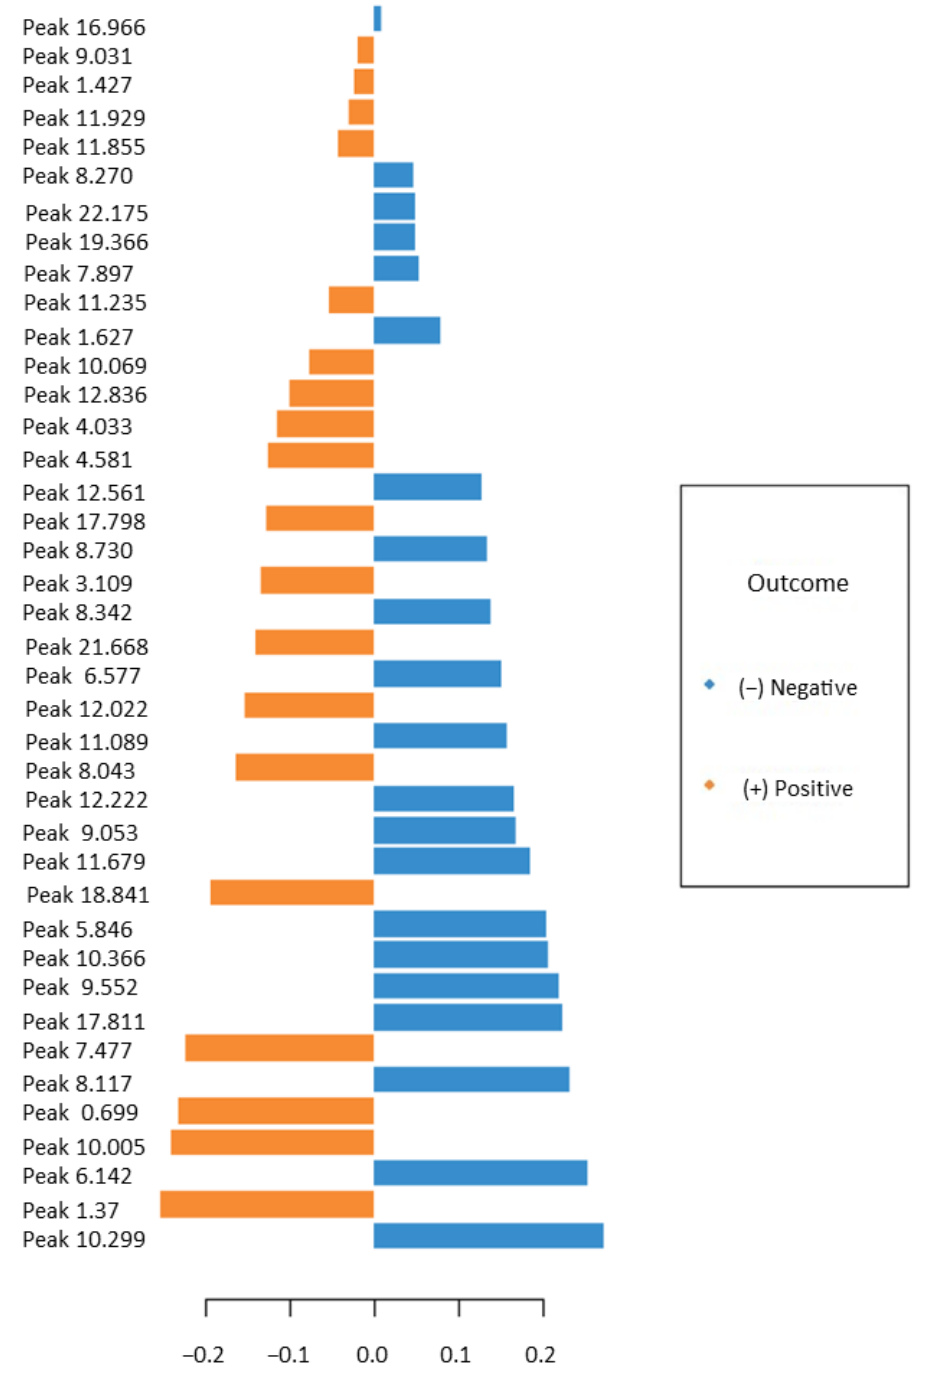
Figure A1. Importance and Feature Contribution of 40 Features of Interest, corresponding to compo- nent 1 in Figure 1.